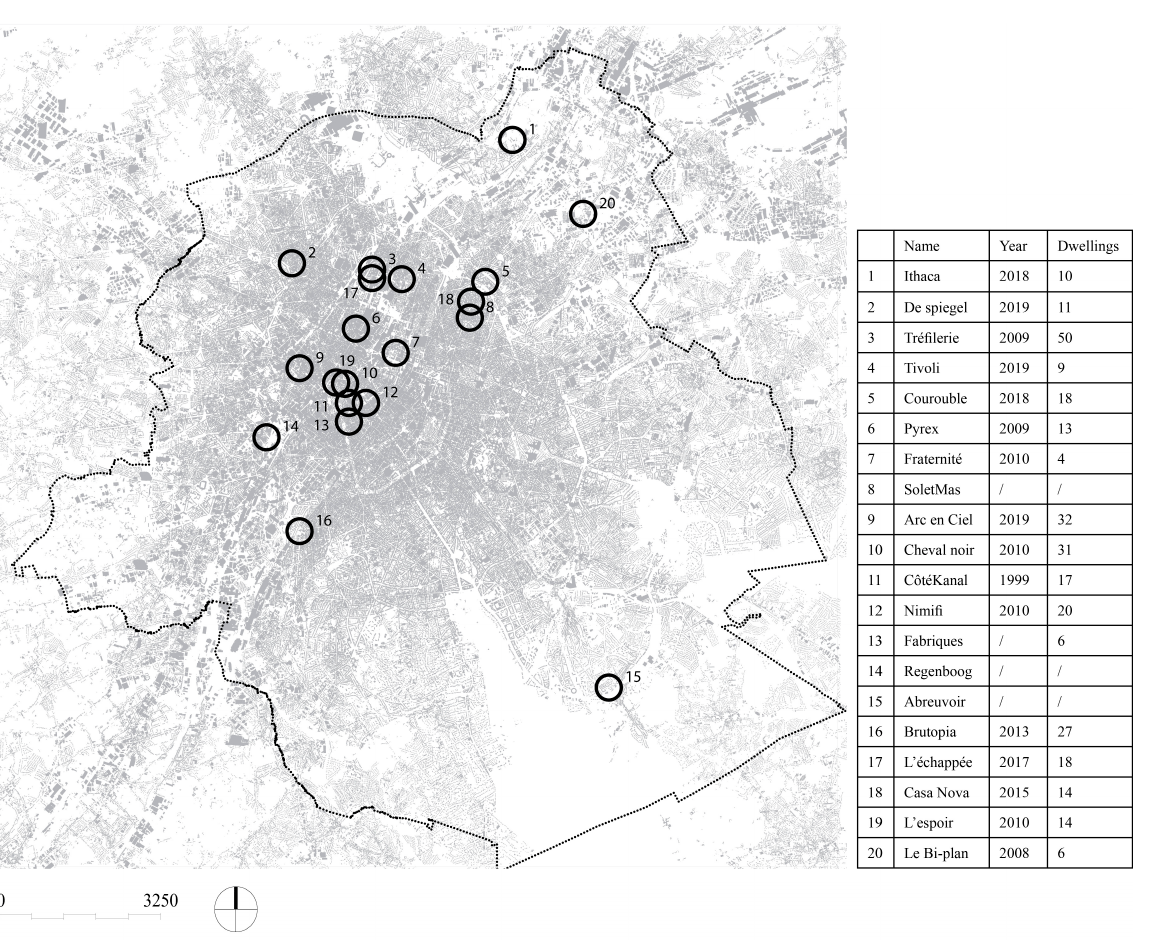
Figure 1. Co-housing projects in the Brussels-Capital region (drawn by the authors, 2019).